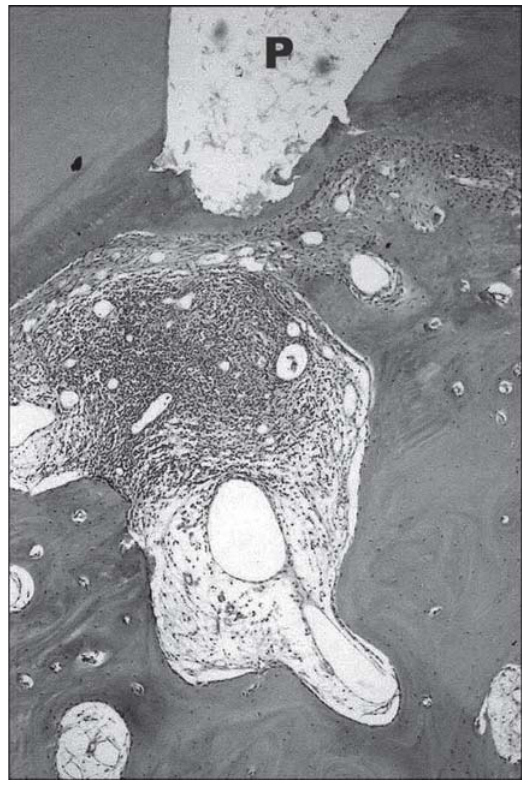
FIGURE 3- WPC, with complete new formation of mineralized tissue at the site of perforation (P), organizing periodontal ligament, regardless of the inflammatory infiltrate. Hematoxylin and eosin – Olympus TABLE 3- Non-parametric Kruskal-Wallis test demonstrating analysis of the inflammatory infiltrate according to the three materials employed